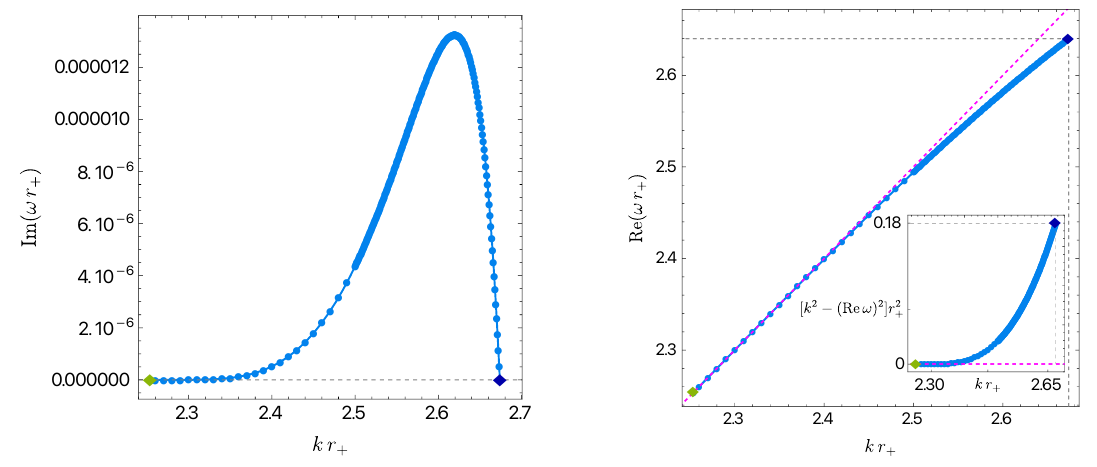
Figure 5 . Frequency for the unstable superradiant mode of Myers-Perry black strings with fixed e Ω H = 0 . 66 , as a function of wavenumber kr + . Left: the imaginary part of the frequency Im( ωr + ) is positive for kr + ∈ ( e k ? , e k ) where the system is unstable to superradiance. The blue diamond (0) on the right with kr + = e k ' 2 . 673761 corresponds to the superradiance onset found in figure 3. (0) √ 1411 One has Im( ωr + ) → 0 as kr + → e k ? = 3 (green diamond on the left side of the plot). Right: 50 the magenta dashed line describes the curve Re ( ωr + ) = kr + . We see that Re( ωr + ) < kr + , and that Re( ωr + ) → kr + as kr + → e k ? from above (this is best seen in the inset plot which displays e k 2 − (Re e ω ) 2 as a function of e k ). This demonstrates that when the instability shuts down at kr + = e k ? , −√ k 2 − ω 2 r ceases to be the fall-off e